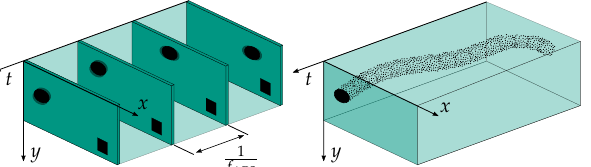
Figure 1. Difference between the frame ( left ) and event-based ( right ) vision technology. The scene shows a sphere moving from the right to left image border and a static square in the lower right corner. A frame-based camera perceives the square as well as the sphere with a motion blur at constant sampling times. The event-based camera does not suffer from motion blur and generates an asynchronous event stream at the edge of the sphere with high temporal resolution. However, the static square is not